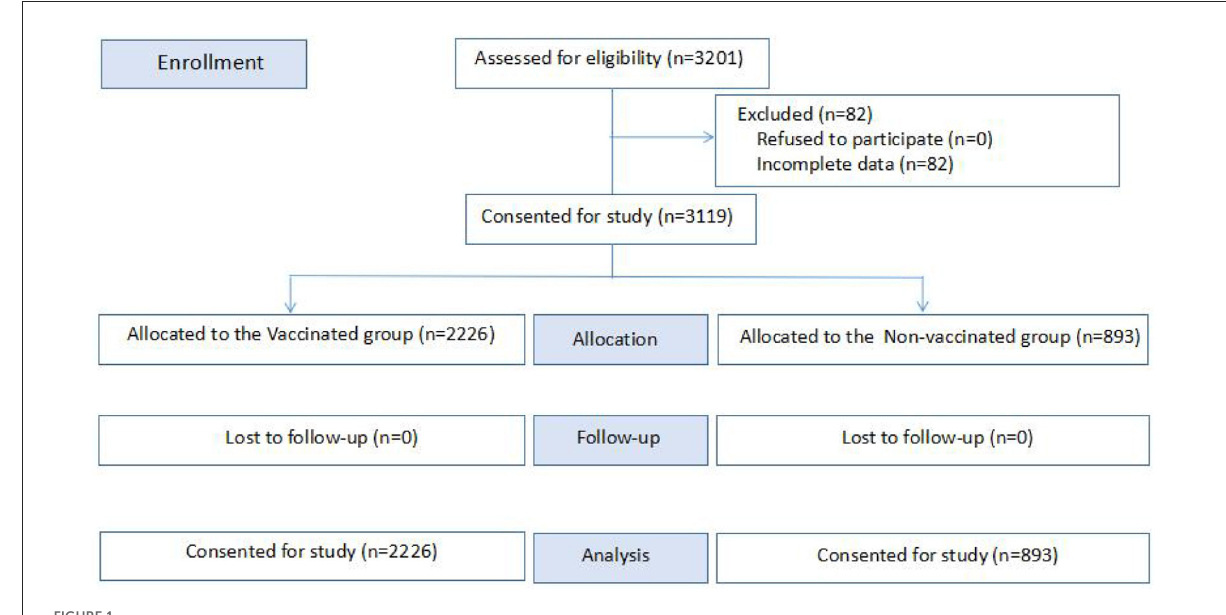
FIGURE1 Case selection